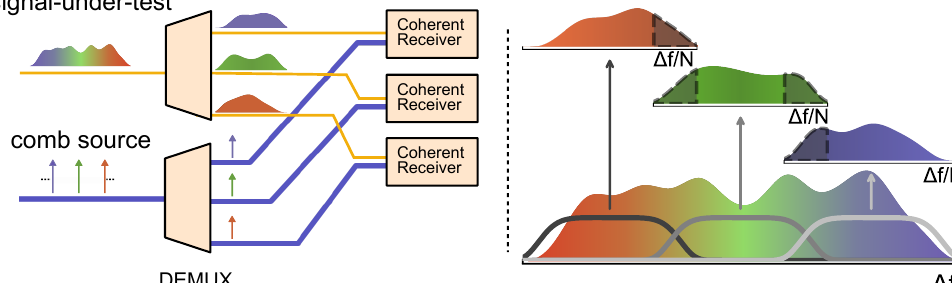
Figure 9. Principle of optical arbitrary waveform characterisation through spectral slicing. ( Left ): A broadband signal under test is demultiplexed using a wavelength division demultiplexer and detected using the lines from a frequency comb source. ( Right ): Phase and amplitude alignment principle. The sub-bands have an overlap region (shaded spectrum) due to the finite response of the demultiplexing